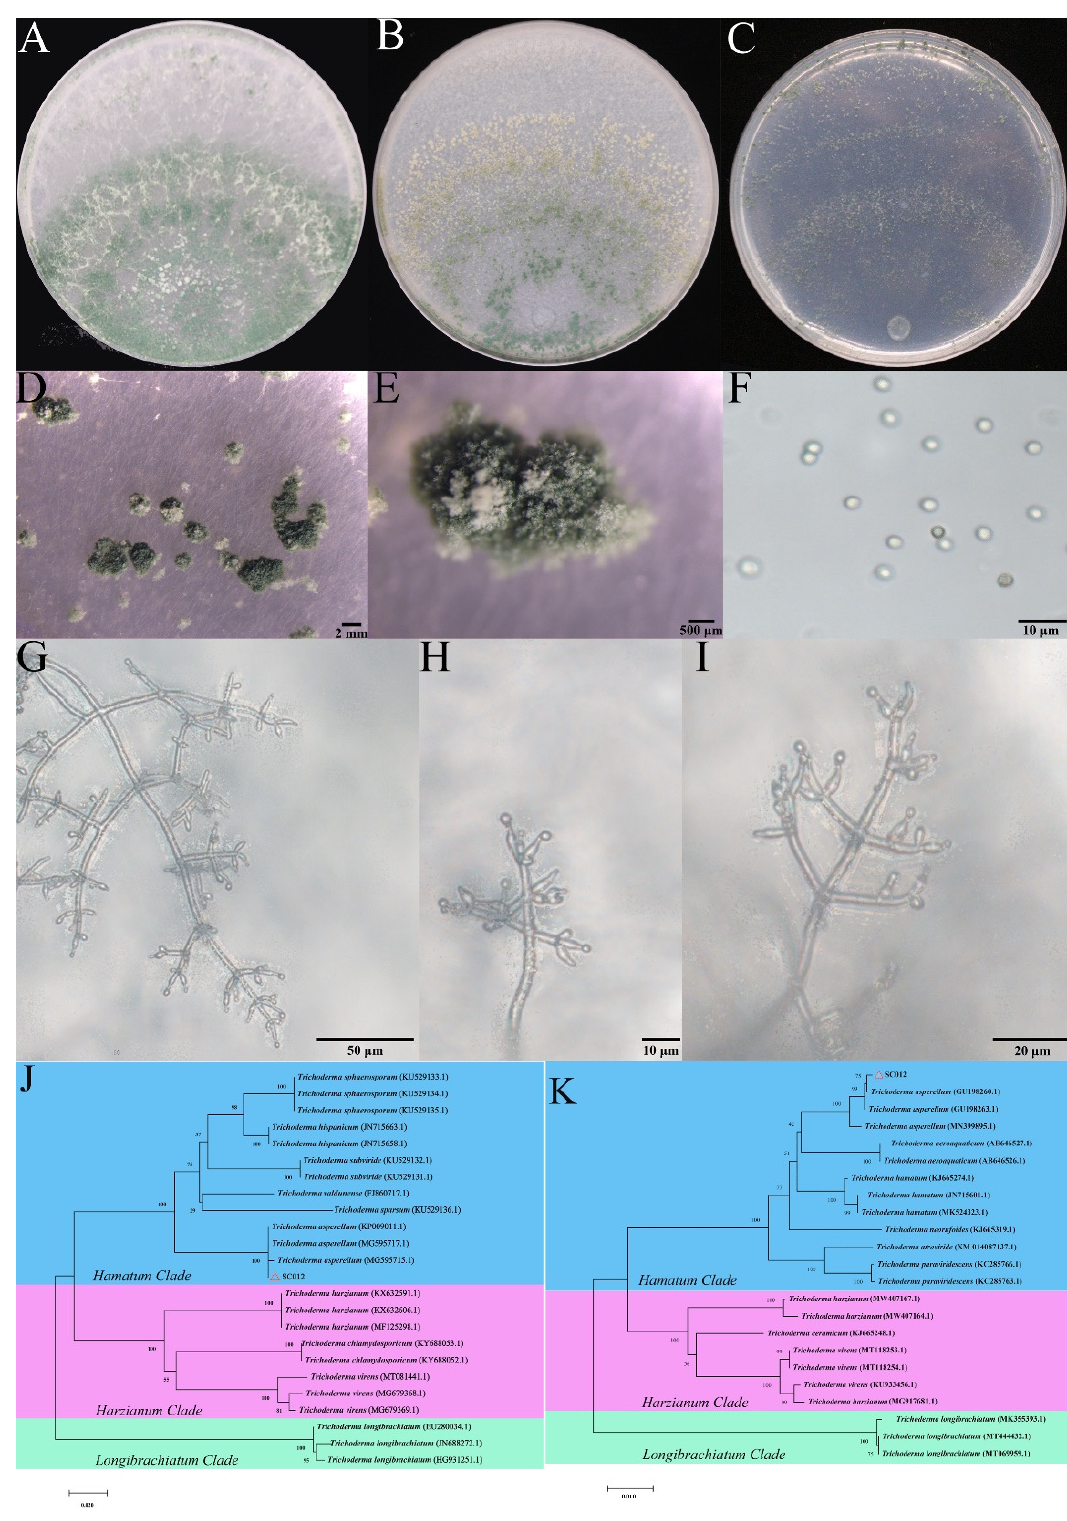
Figure 1. Morphology and molecular analysis of Trichoderma SC012 strain. ( A – C ) The morphology of colony grown on PDA, CMD and SNA medium, respectively; ( D , E ) the morphology of a conidial pustule grown on CMD plates; ( F ) morphology of the conidia and chlamydospores; ( G – I ) the morphology of conidiophores; ( J ) neighbor-joining tree based on translation elongation factor 1 ( tef 1) gene sequences and evaluated by 1000 bootstrap replications; ( K ) neighbor-joining tree based on RNA polymerase subunit II ( rpb 2) gene sequences and evaluated by 1000 bootstrap replications.